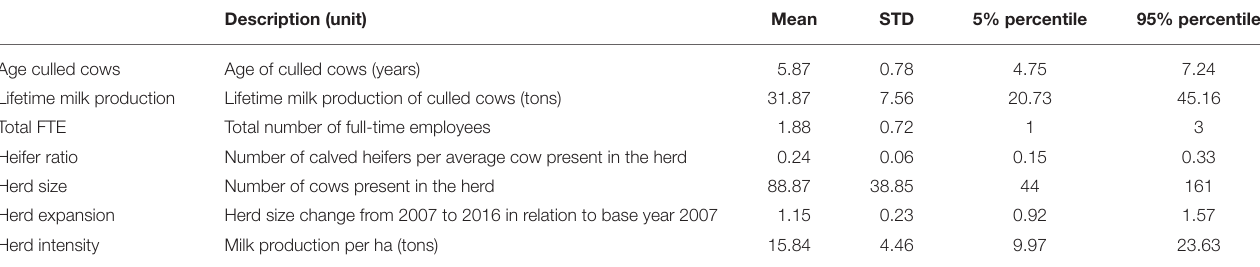
TABLE 1 | Descriptive statistics on continuous variables over herds and years ( n = 855